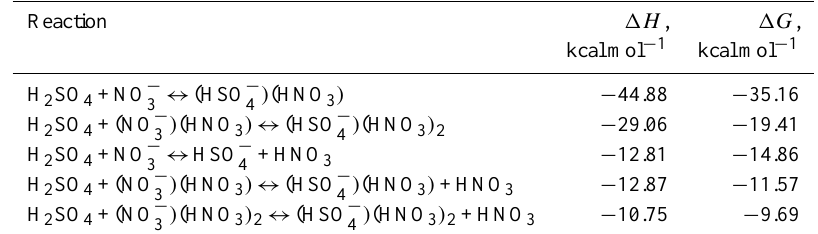
Table 3. Thermochemical parameters (at the PW91/6-311++G(3df, 3pd) level) for the clustering reactions of sulfuric acid with nitrate– nitric acid ions. All values correspond to 298K and 1atm reference pressure for all